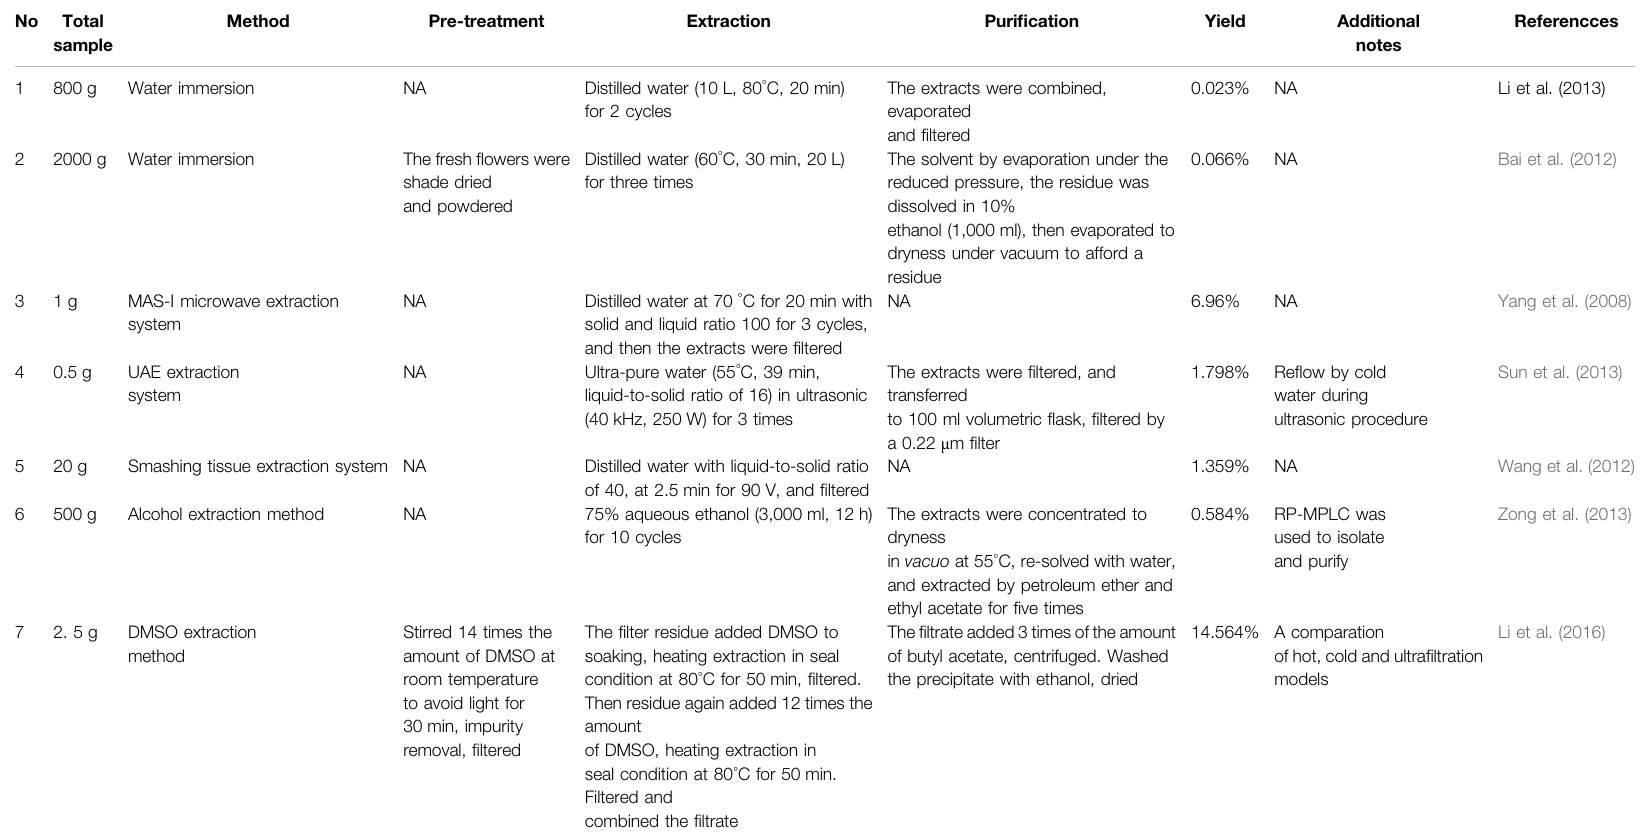
TABLE 1 | Representative examples of the extraction and puri fi cation methods of